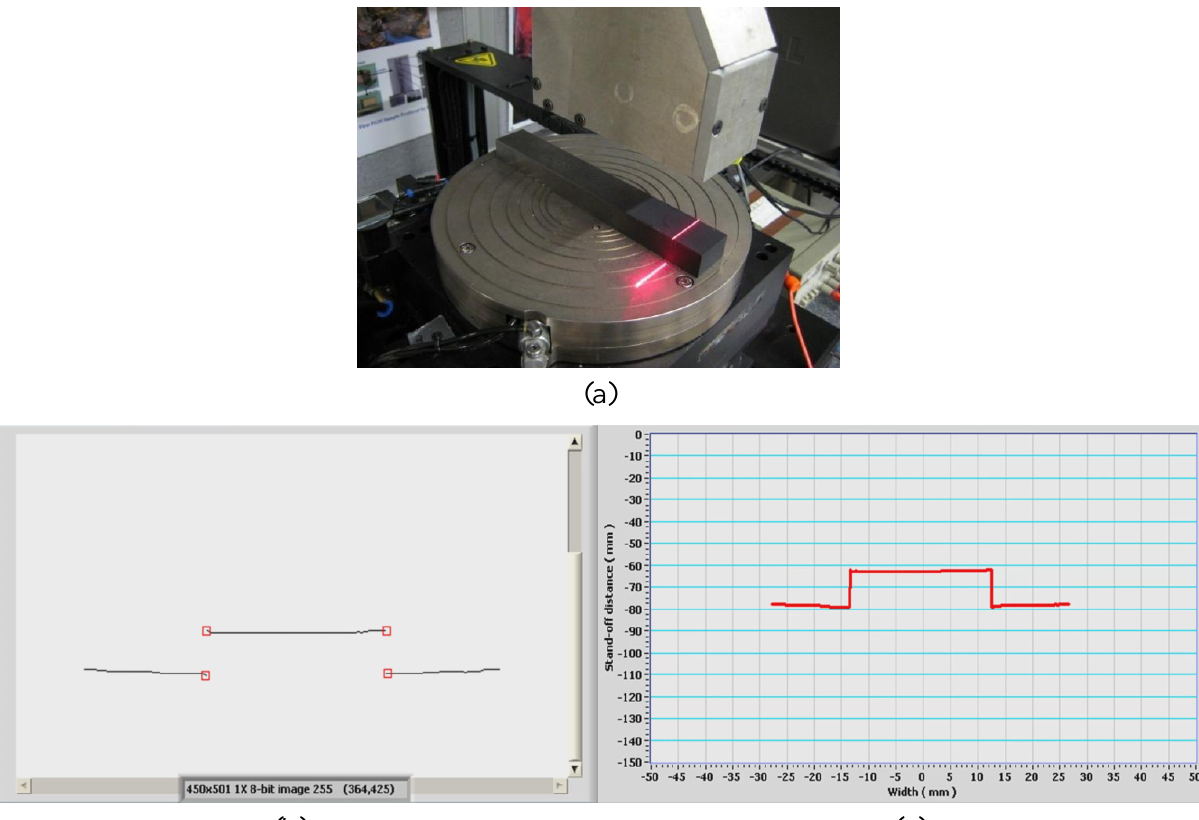
Figure 4. Calibration of vision system: (a) setup for the system calibration; (b) detected corner points of the reference coupon in the pixel space; (c) detected corner points of the reference coupon in the coordinate